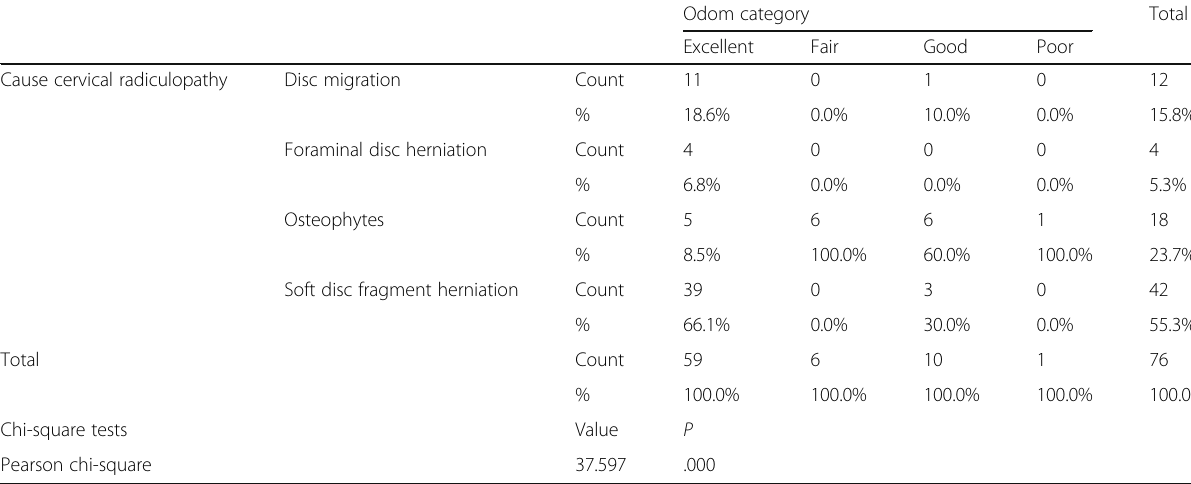
Table 3 Odom ’ s category in relation to offending pathology